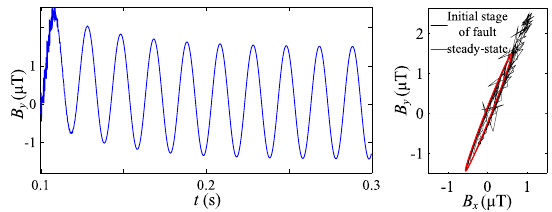
Fig. 14 B y original waveform and dual-axis synthetic